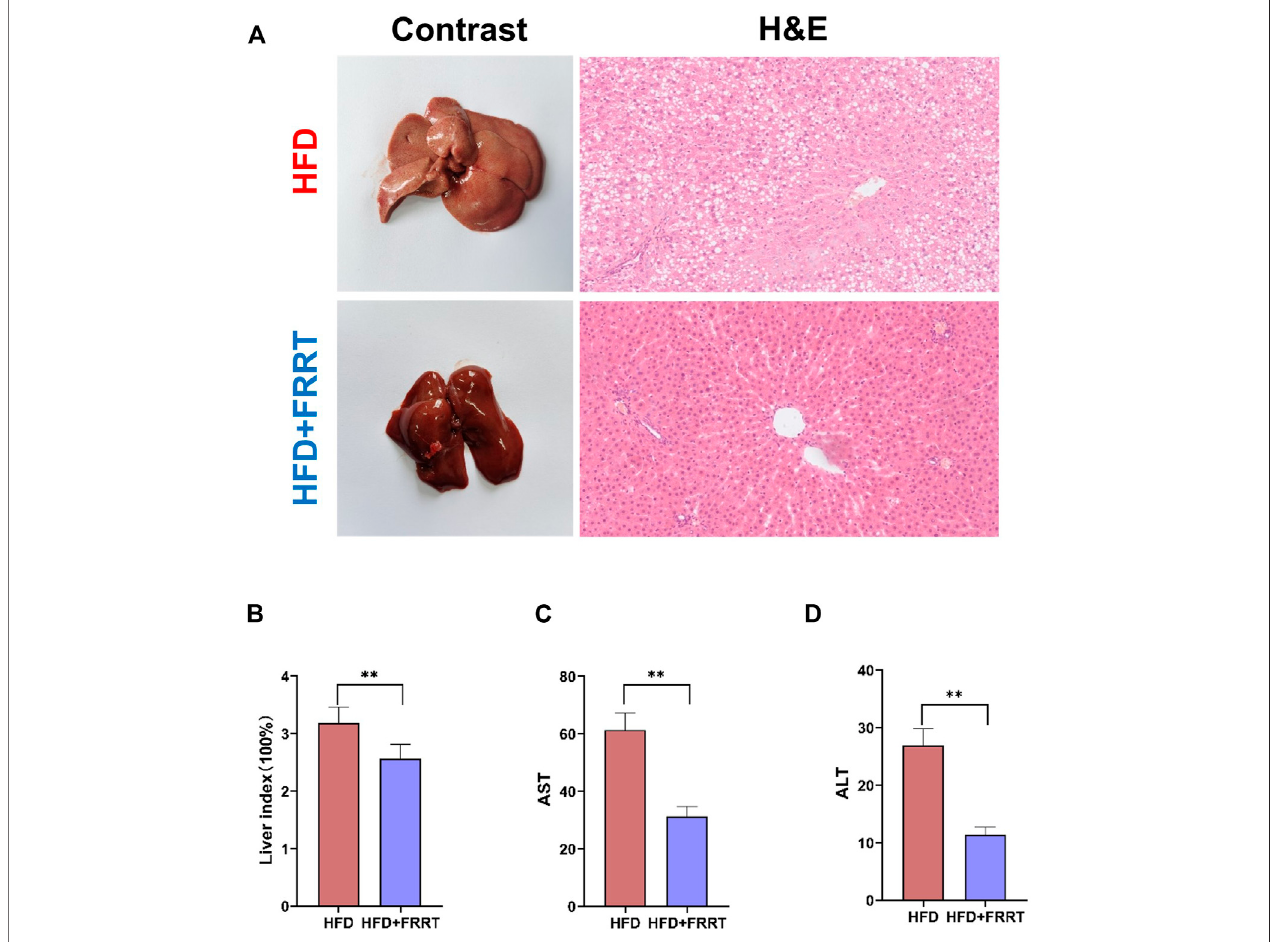
FIGURE 2 | FRRT improves liver function damage in hyperlipidemic rats. (A) H&E staining images and morphology of Liver. (B) Changes in the liver index. Serum AST (C) and ALT (D) levels were measured using commercial kits. Data are presented as mean ± SEM ( n = 6). * p < 0.05, ** p < 0.01 compared with HFD group.